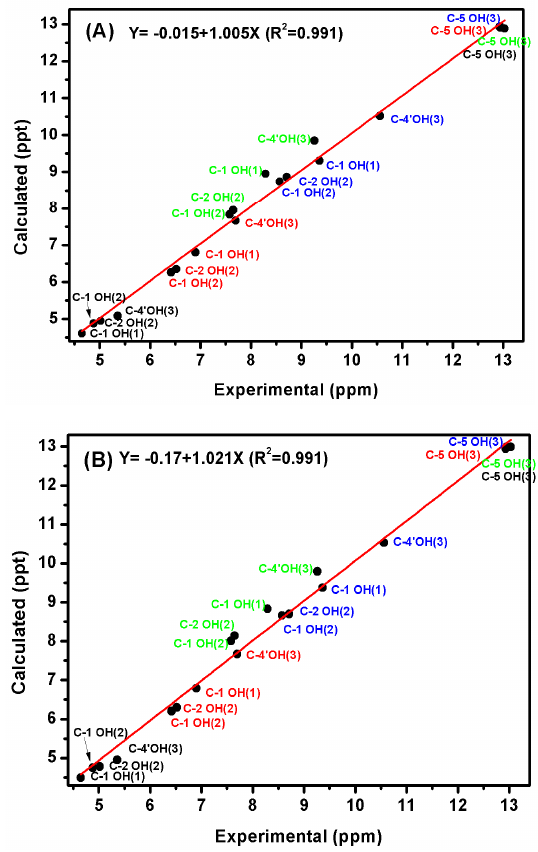
Figure 6. Calculated (at the GIAO DFT/B3LYP/6-311++G(2d,p) level of theory) vs. experimental values of the chemical shifts of the –OH protons of phenol, 4-methylcatehol and genkwanin (Figure 5) in DMSO (yellow), acetone (green), CH 3 CN (red), and CHCl 3 (blue), with minimization of the complexes with a single solvent molecule at the DFT/B3LYP/6-31+G(d) ( A ) and DFT/B3LYP/6-311++G(d,p); ( B ) level of theory. Adopted, with permission, from [46]. Copyright 2013, The Royal Society of Chemistry.